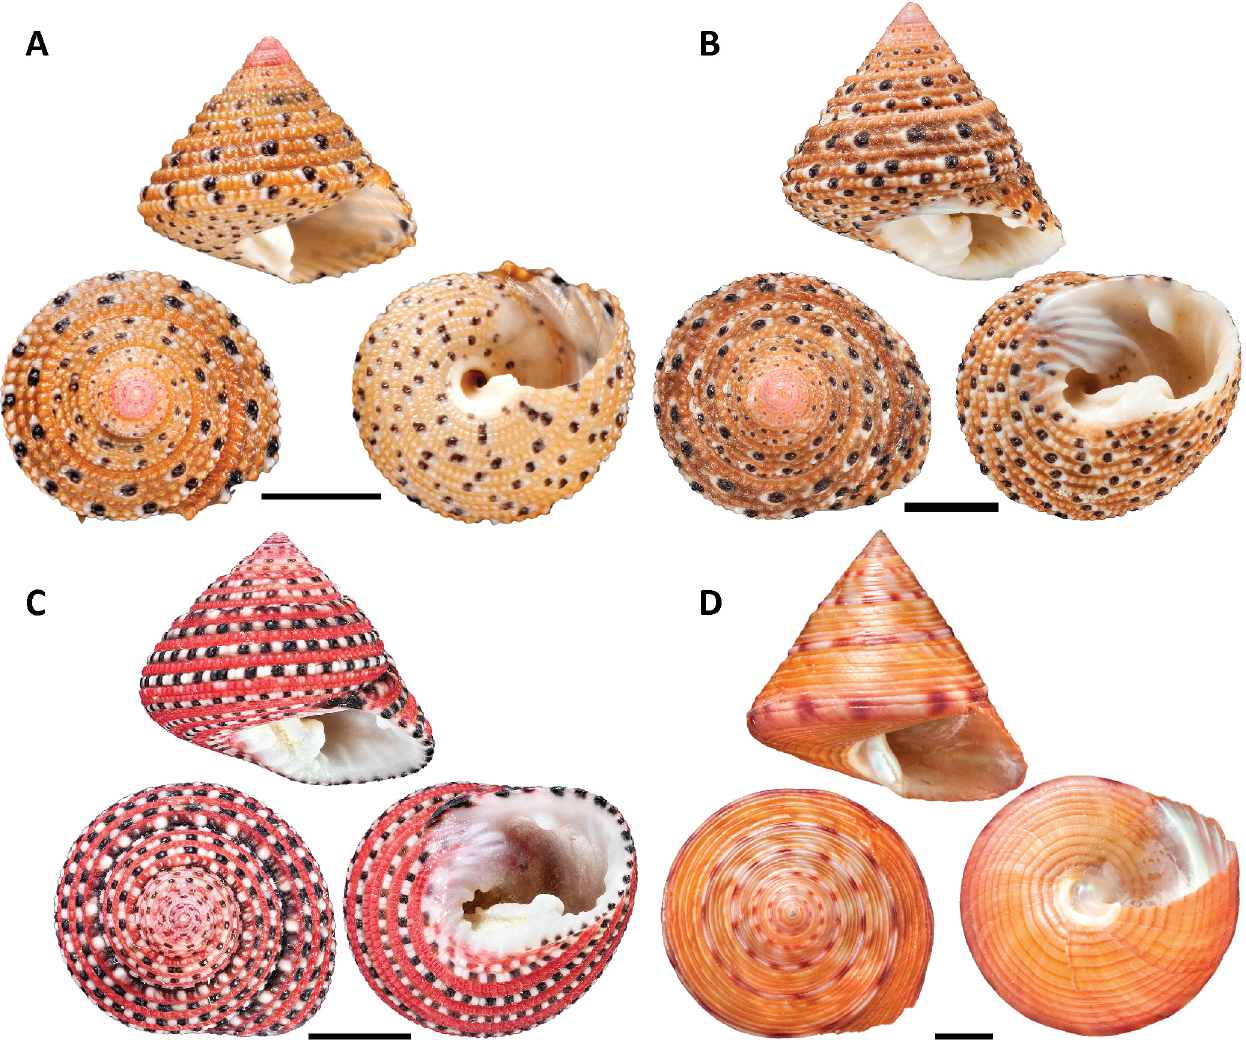
Fig 1. Photos of exemplar specimens. (A) Clanculus margaritarius A. Shell from Kitahama, Japan. Note that the specimen is sub adult. Specimen # 3. (B) Clanculus margaritarius B. Shell of an unlocalised specimen, NHMUK collection. Specimen # 10. (C) Clanculus pharaonius . Rose Reef, Thuwal, Saudi Arabia. Specimen # 4. (D) Calliostoma zizyphinum . Shetland Islands, United Kingdom. Specimen # 1. Scale bars = 5 mm, except in (D), where scale bar = 1